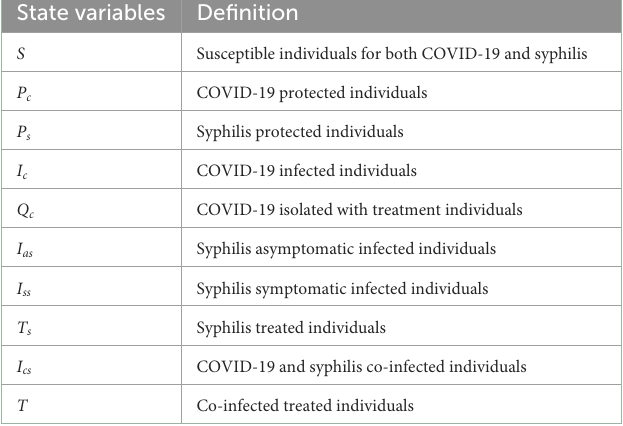
TABLE 1 Variables’